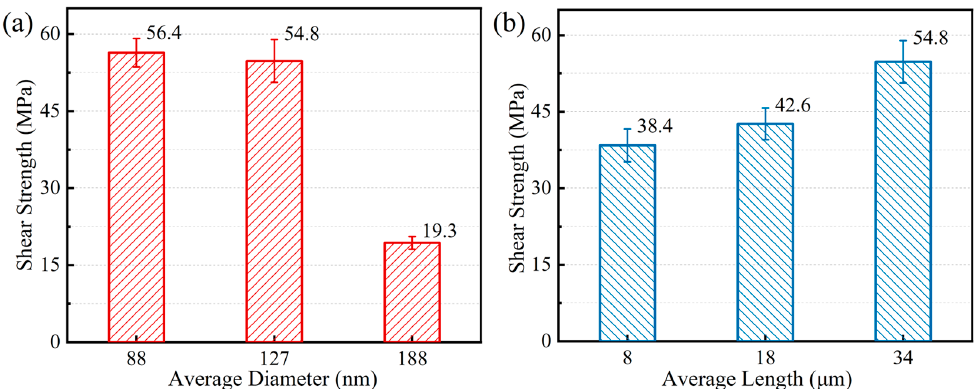
Figure 11. Shear strength of the joints attached by sintered silver nanowire film prepared with different sizes of the silver nanowire. ( a ) Silver nanowire films prepared with silver nanowires (1), (2), and (3) in Figure 1. ( b ) Silver nanowire films prepared with silver nanowires (4), (5), and (2) in Figure 1.